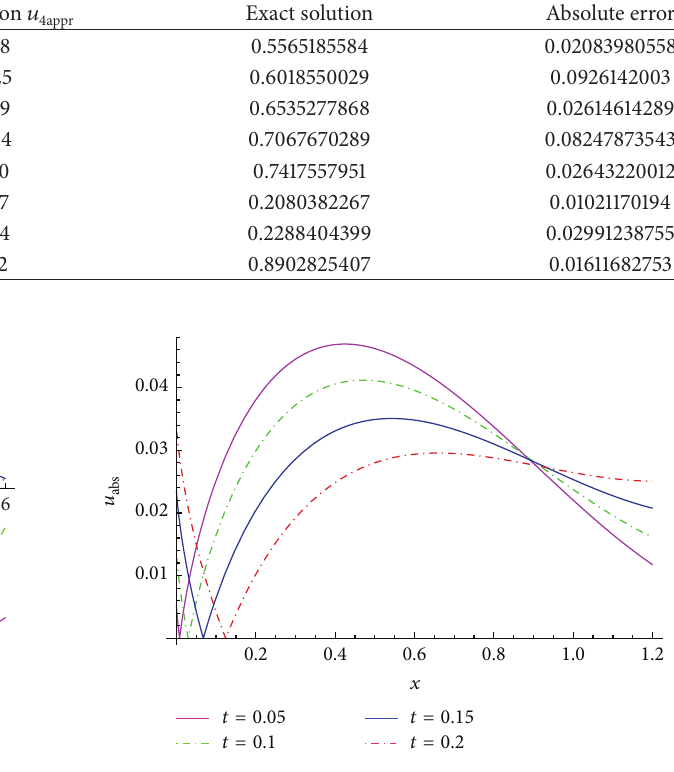
when 𝛼 = 0.7 and 𝛽 = 0.9 abs